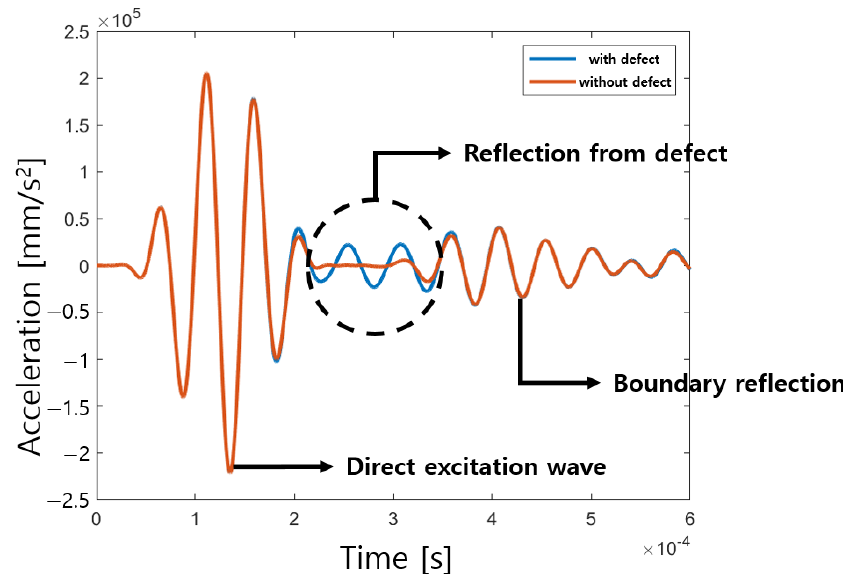
Figure 9. Time responses of panel with and without defect at 20 kHz excitation. Table 3. Summed magnitudes of defect-induced reflective waves for each excitation location.